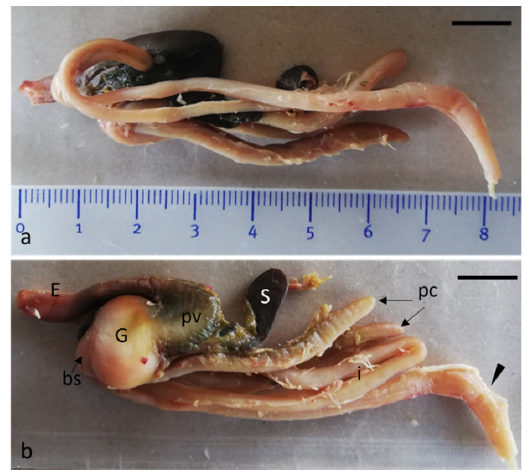
Figure 3. Gross anatomy. ( a ) Photograph of the left side of the gastrointestinal tract. ( b ) Photograph of the right side of the gastrointestinal tract: esophagus (E), proventriculus (pv), gizzard (G), crani- oventral blind sac (bs), spleen (S), pyloric appendages (pc), intestine (i), rectum (arrowhead). Scale bar: 1 cm.